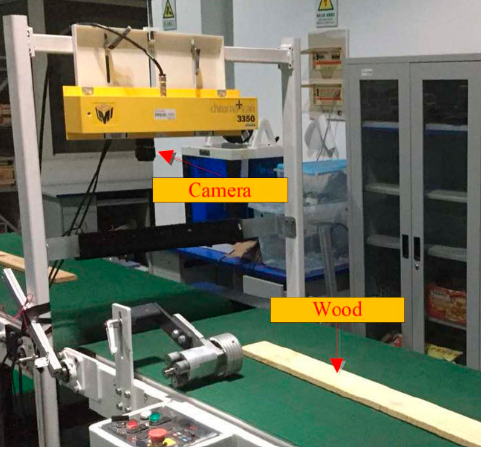
Figure 12. Wood image acquisition equipment.